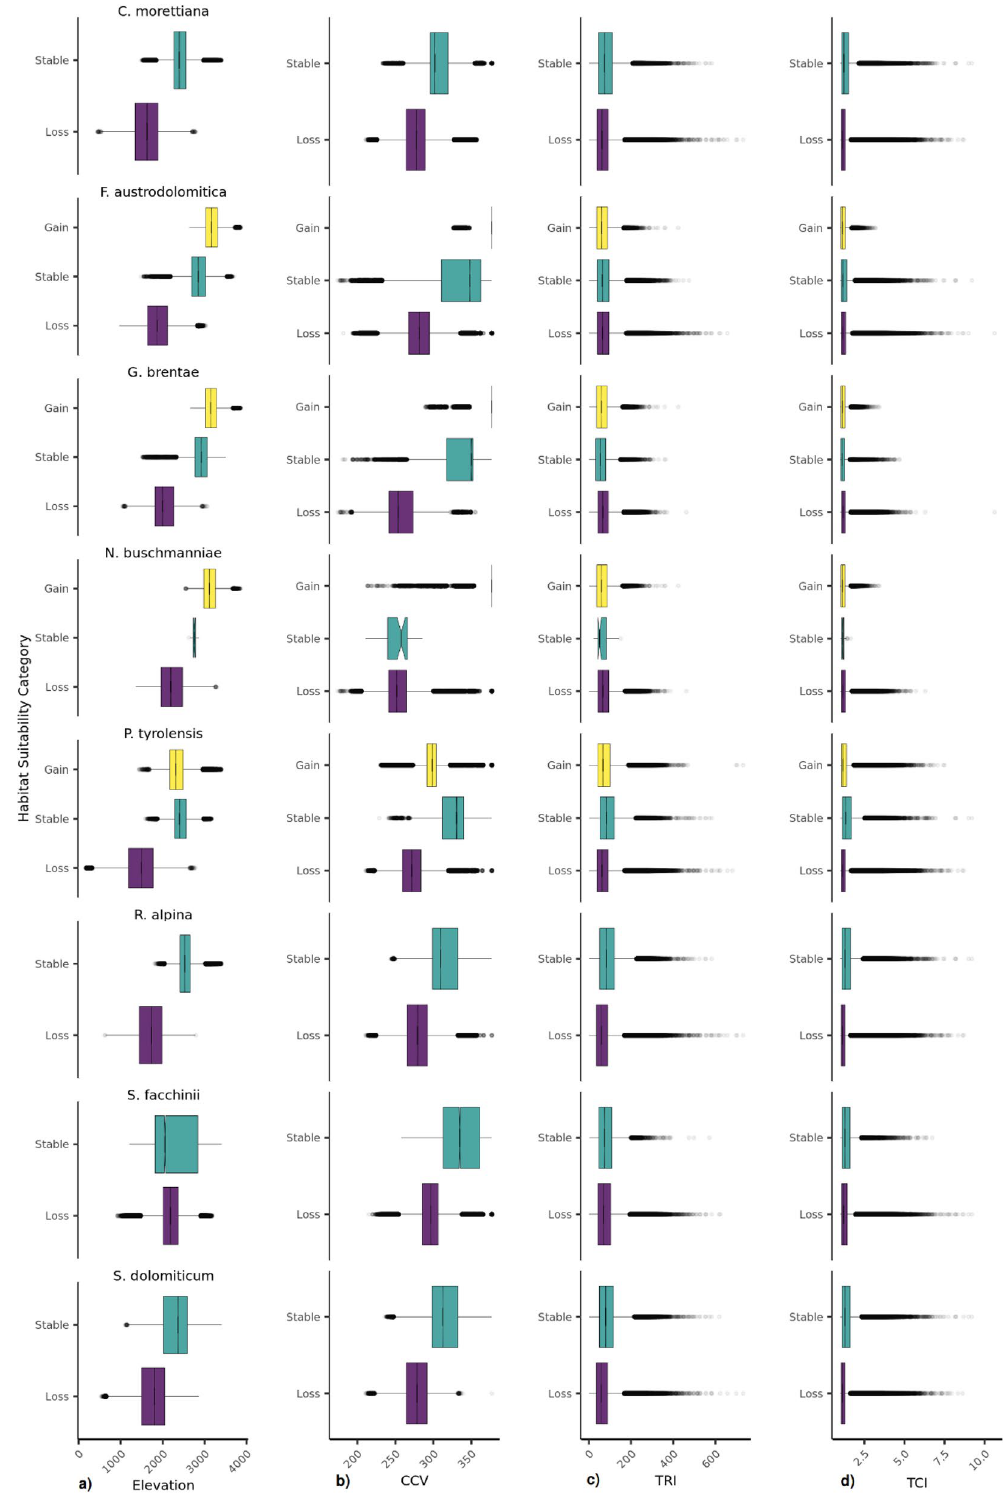
Figure 3. Boxplot for each category of habitat suitability (loss, stable, gain) for the realistic rcp 8.5 scenario for ( a ) elevation (m a.s.l.), ( b ) climate change velocity (log10(m yr −1 )*100), ( c ) topographical ruggedness index (TRI) and d topographical complexity index (TCI) for each of the eight study species. After the pairwise Mann– Whitney tests all the categories showed significant differences, with the following non-significant exceptions for the rcp 8.5 scenario: stable areas compared to lost areas for TCI in F. austrodolomitica ; stable areas compared to lost and gained areas for both TCI and TRI in N.